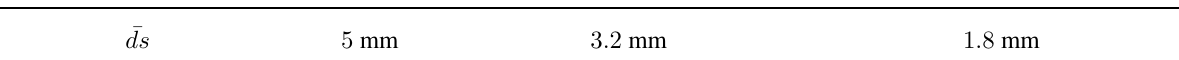
Table 3. The mean standard deviation of distance discrepancies of representative points in the four epochs (the second column result comes from [14] without fine registration; “six-parameter transformation” means the result from fine registration with the ICP method; and “ seven-parameter transformation” means the result from fine registration with the help of the SVD algorithm).